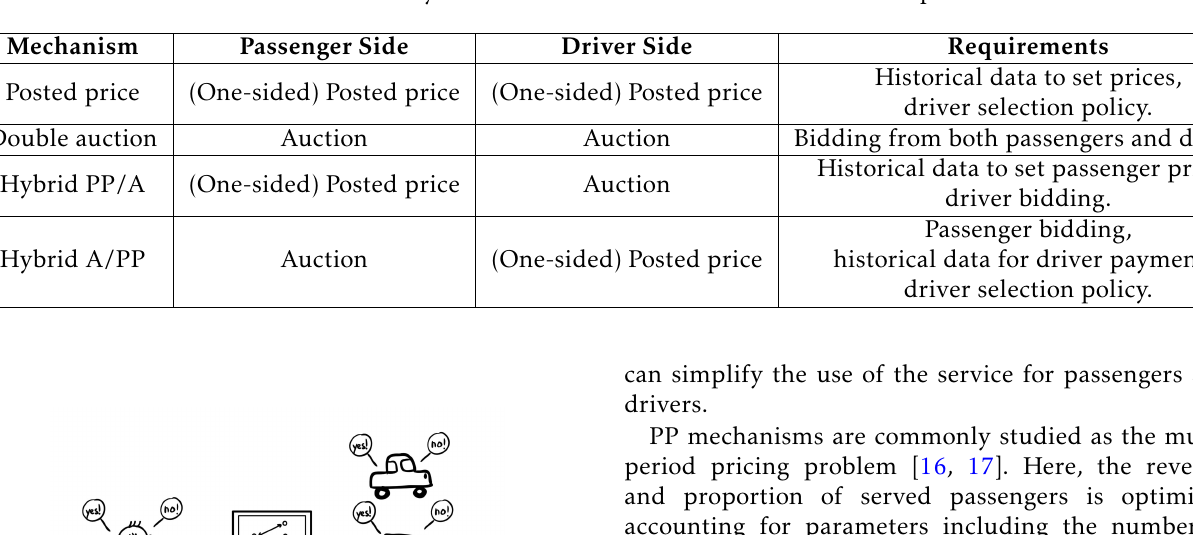
Table 1. Summaryof FrameworkforMechanismsin On-DemandTransport.